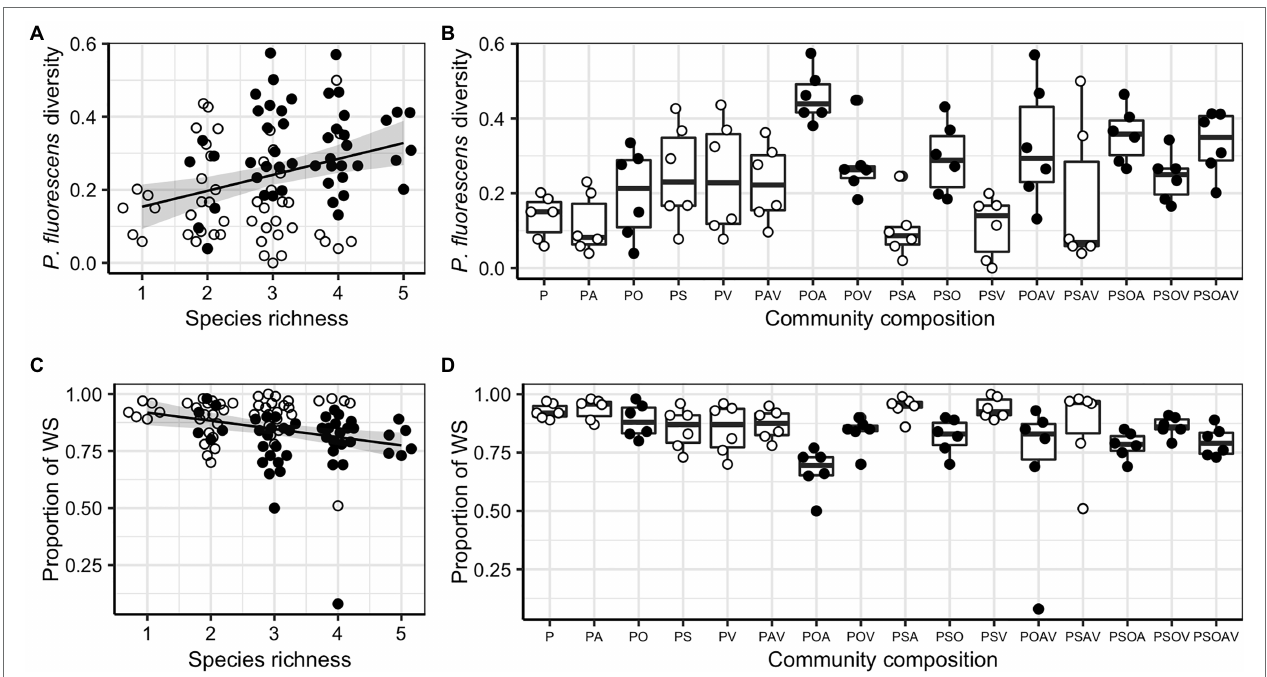
FIGURE 3 | The effect of species richness, the presence of Ochrobactrum sp. (O) and community composition on Pseudomonas fluorescens diversity (A,B) and the proportion of wrinkly spreader ( WS; C,D) . For both responsive variables, regression lines showed significant linear relationships with species richness: y 0.110 0.044x = + , F 1,94 = 369.820, p < 0.001, adjusted R 2 = 0.088 (A) ; and 0.954 0.036x y = − , F 1,94 = 8.061, p = 0.006, adjusted R 2 = 0.069 (B) . Shaded areas around lines show the 95% confidence intervals. Treatments containing O (filled dots) and not containing O (open dots) are highlighted to show the sampling effect of O. Tops and bottoms of the bars represent the 75th and 25th percentiles of the data, the middle lines are the medians, and the whiskers extend from their respective hinge to the smallest or largest value no further than 1.5 × interquartile range. TABLE 1 | Analysis of variance table of F -values on the effects of presence of specific species, and species richness on the diversity of Pseudomonas fluorescens populations. Achromobacter sp. Ochrobactrum sp. Stenotrophomonas sp. Variovorax sp. Factor df